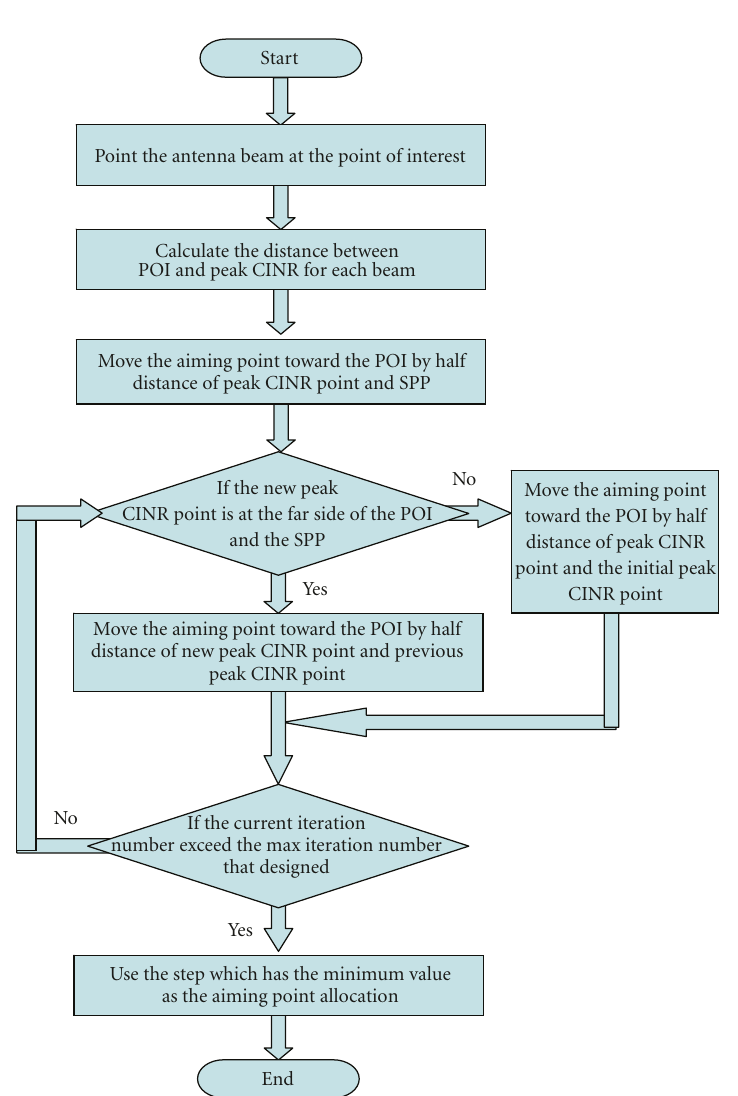
Figure 10: The flowchart of the half distance step side